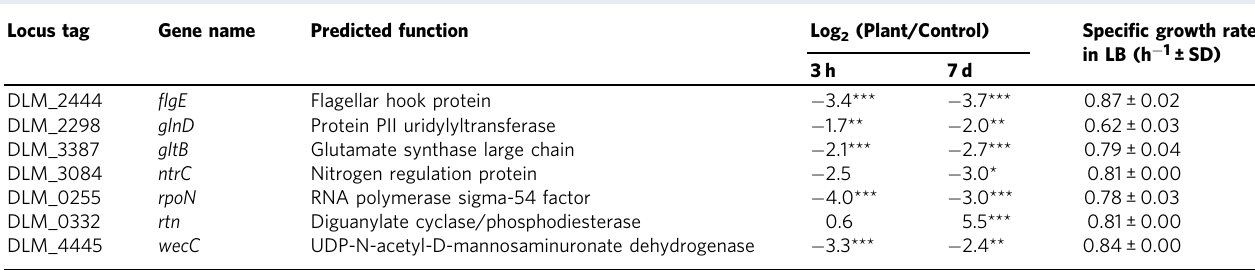
Table 1 Genes selected for the validation experiments.